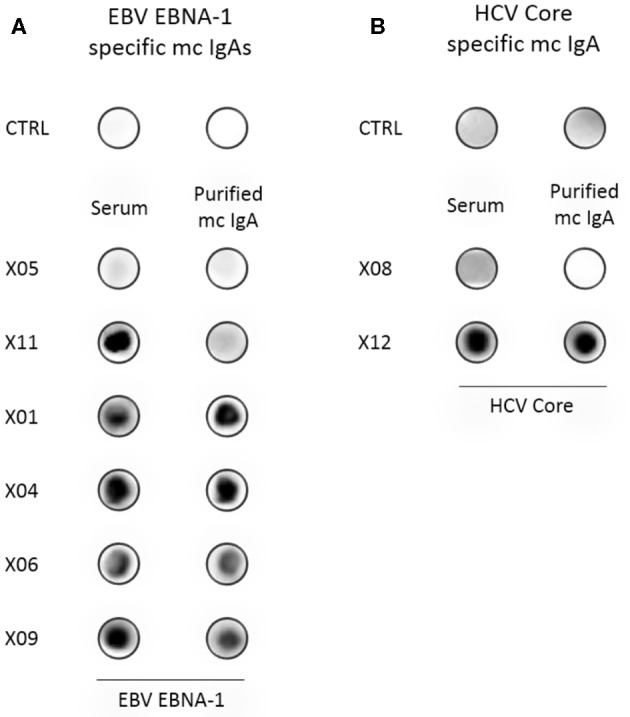
Confirmation of the specificity of recognition of EBV EBNA-1 or HCV core proteins by purified monoclonal IgAs. (A) Dot blotting assays with purified recombinant EBNA-1 were performed in parallel with PBS, as control (CTRL), and with the serum and the purified monoclonal IgA from six patients. As assessed by the MIAA array, both serum and purified monoclonal IgAs of the patient X05 did not recognize EBV EBNA-1, and only unseparated IgAs from the serum of the patient X11 recognized EBNA-1 (negative controls). For patients X01, X04, X06, and X09, both serum and purified monoclonal IgAs recognized EBV EBNA-1, thus confirming the results obtained with the MIAA array. (B) A dot blotting assay with purified recombinant HCV core protein was performed in parallel with PBS, as control (CTRL), and with the serum and purified monoclonal IgA of patients. As assessed by the MIAA array, both the serum and the purified monoclonal IgA of patient X08 did not recognize the HCV core (negative control). For patient X12, both the serum and the purified monoclonal IgA recognized the HCV core, confirming the results obtained with the MIAA array. Experiments were performed at least twice.